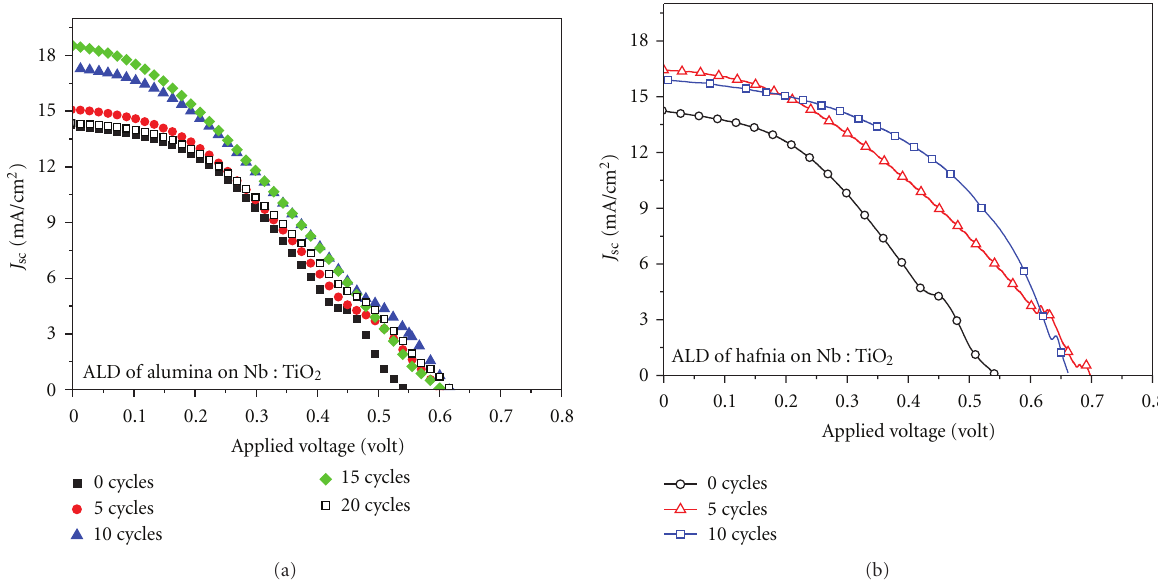
Figure 1: The J - V curves for DSCs composed of ALD of alumina on Nb :TiO 2 photoanode (a) and of hafnia-coated one (b) treated with di ff erent cycles.